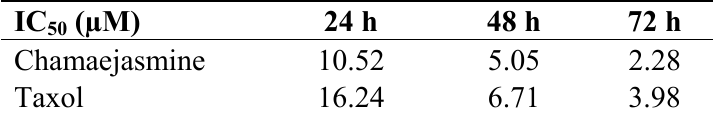
Table 2. Effect of chamaejasmine towards PC-3 cells as determined by the MTT assay at different